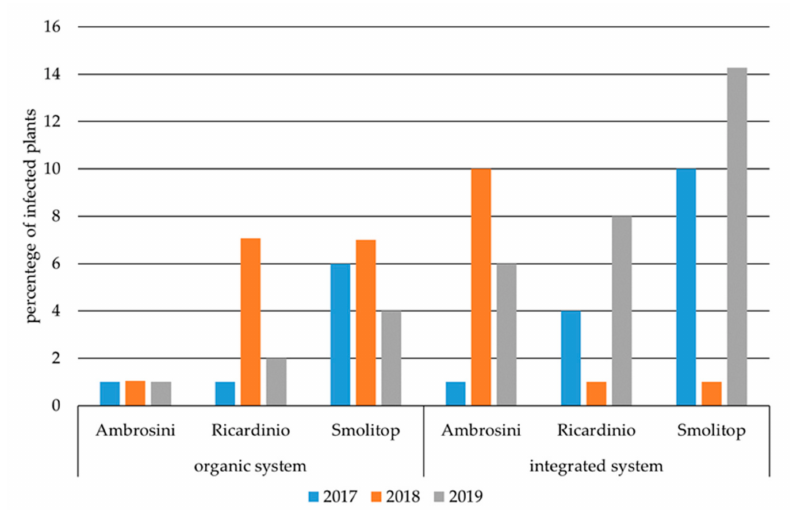
Figure 5. Percentage of plants with corn smut in three maize varieties (Ambrosini, Ricardinio, Smolitop) in the years 2017–2019 in two cultivation systems. There were no significant differences among varieties within cultivation systems, according to the ANOVA analysis of variance at p ≤